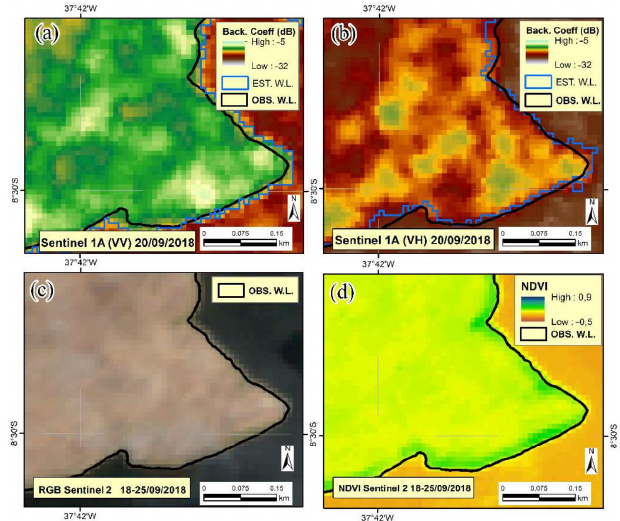
Figure 18. Typical depletion zone image features in the dry season: ( a ) VV backscattering; ( b ) VH backscattering; ( c ) RGB composition; and ( d ) NDVI composite. OBS. W.L indicates observed water level.